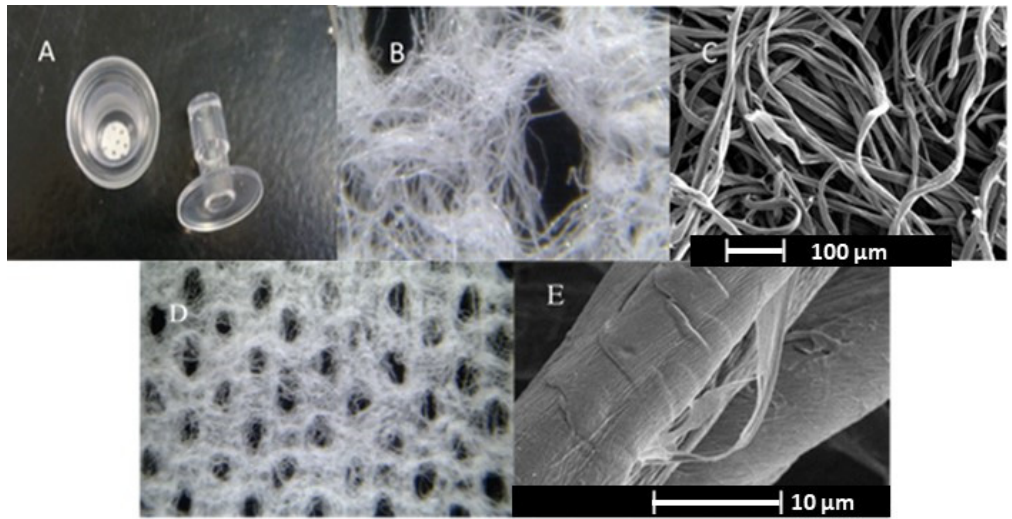
( B ) hydroentangled greige cotton magnification 130 × ; ( C ) SEM of greige cotton fibers. Note cracks in the cuticle where pectin and absorbent cellulose are exposed and; ( D ) hydroentangled greige cotton magnification 26 × ; ( E ) SEM of greige cotton fiber taken from a nonwoven showing cuticle lifted above the surface from pressure of waterjets during HE